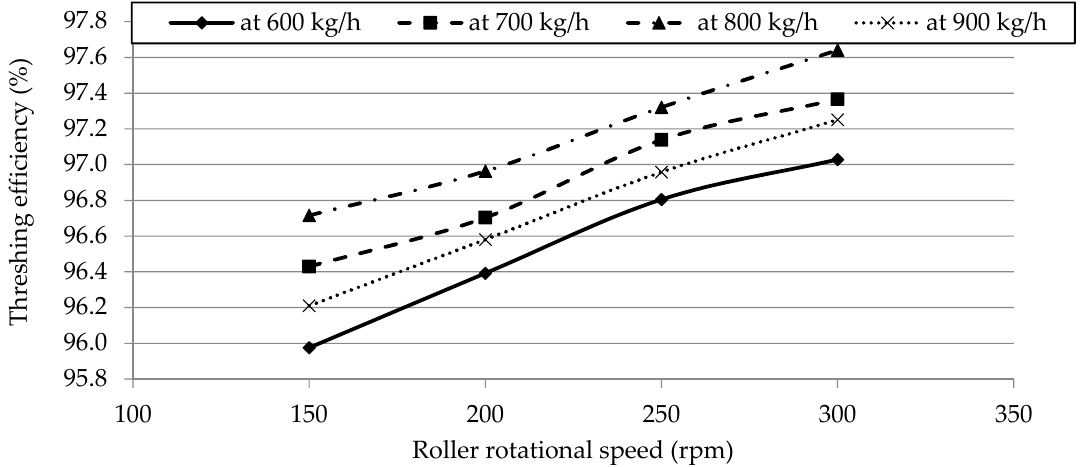
Figure 6. Effect of the roller’s rotational speed (rpm) on the threshing efficiency (%) at different feed rates (kg/h). 3.4. Effect of the Roller’s Rotational Speed on the Machine’s Productivity at Different Feed Rates